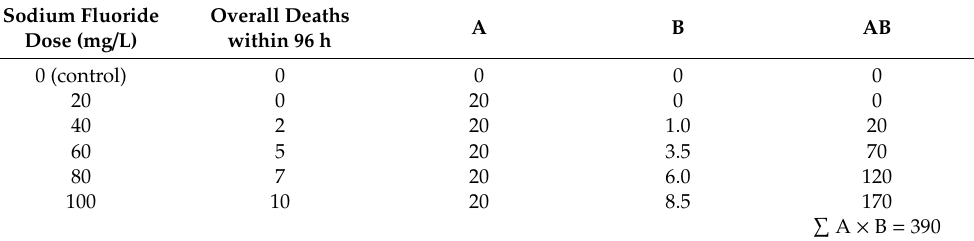
Table 3. Determination of sodium fluoride LC50 in O.